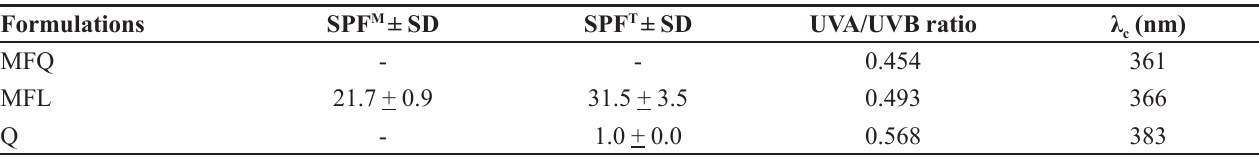
TABLE II - In vitro assessment of Solar Protection Factor (SPF M ) (according to Mansur´s method) and SPF T (UV transmittance analyzer), UVA/UVB ratio and critical wavelength (λ